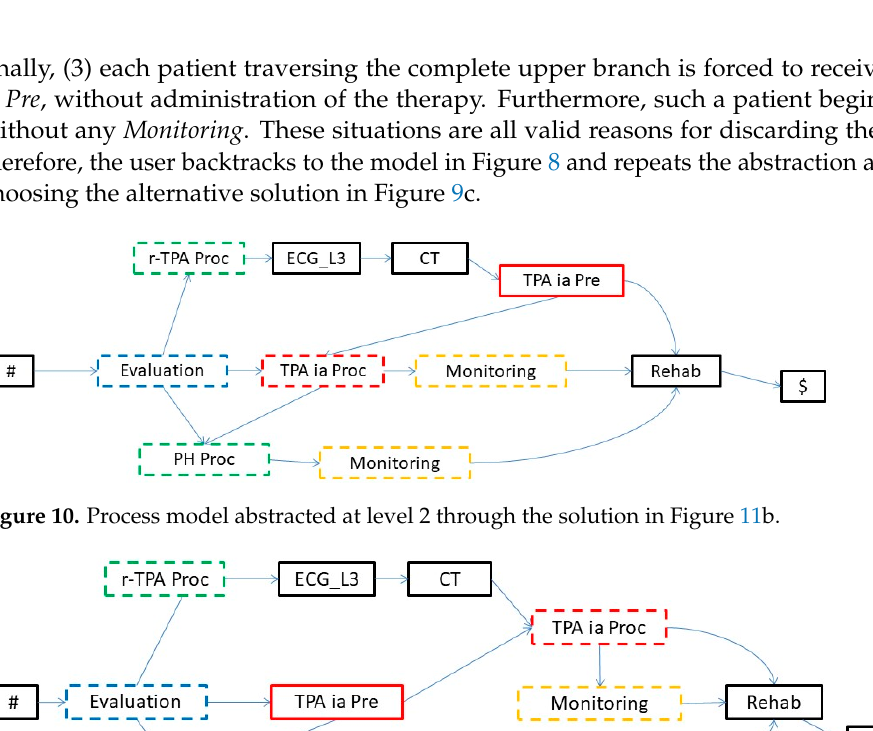
Figure 11. Process model abstracted at level 2 through the solution in Figure 9c.